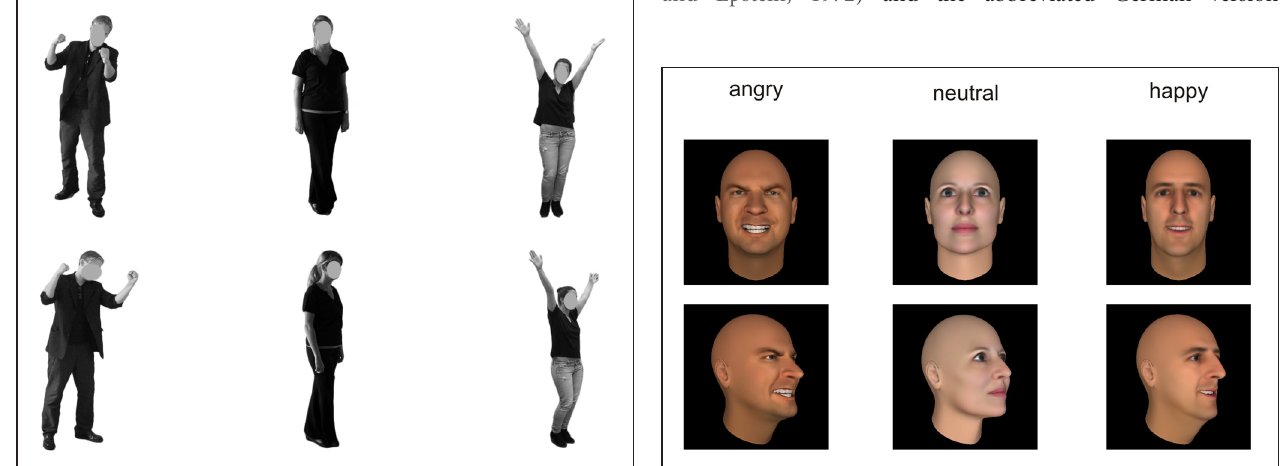
FIGURE 1 | Examples of the presented stimuli depicting bodies from a frontal (top) and averted (bottom) perspective.